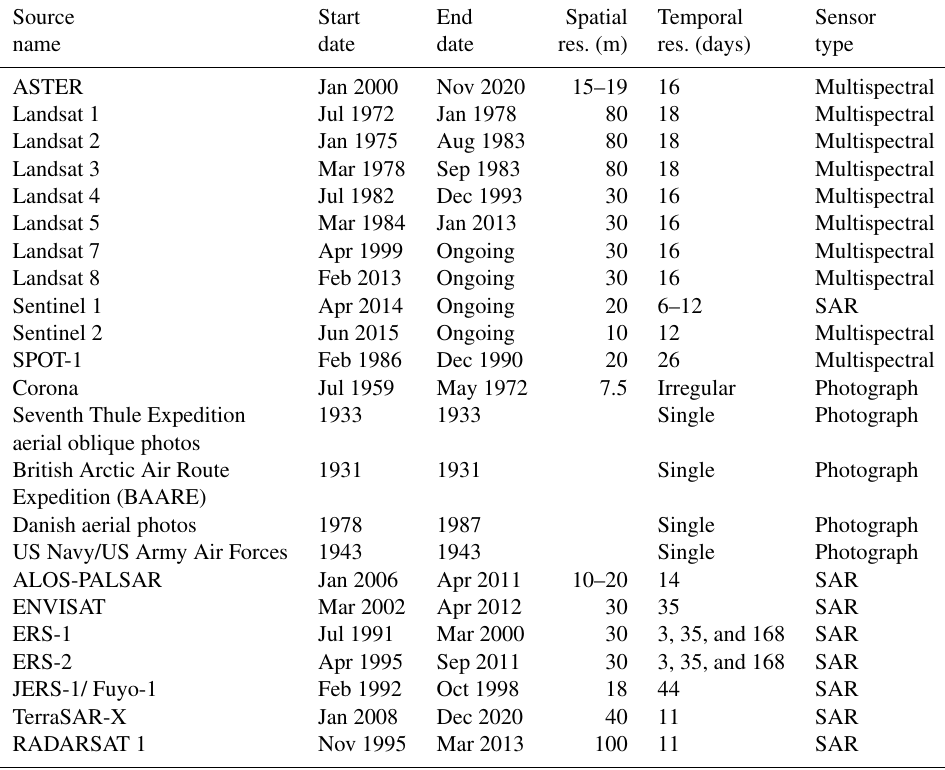
Table 2. Image sources used in this compilation of manually traced glacier terminus trace data set. SAR signifies synthetic aperture radar. Source